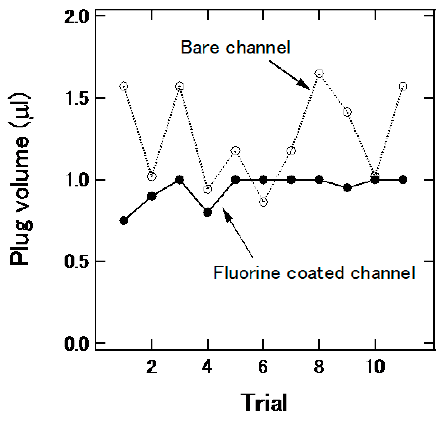
Figure 6. Effect of fluorine treatment of channel on the variation of plug volume.